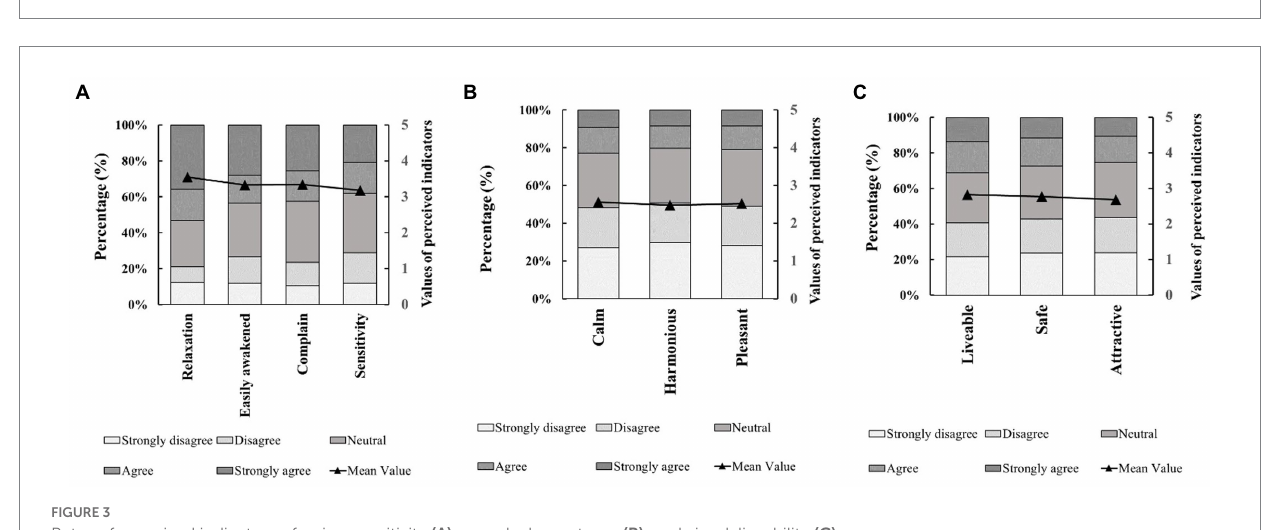
FIGURE 2 Top view (A) , front view (B) , and photo (C) of the experimental setup (C) . Details of equipment and portable structure (1) headphones, (2) tablet, (3) columns, (4) curtain rails, (5) curtain, (6) sonometer, (7) dummy head, and (8) swivel chair.